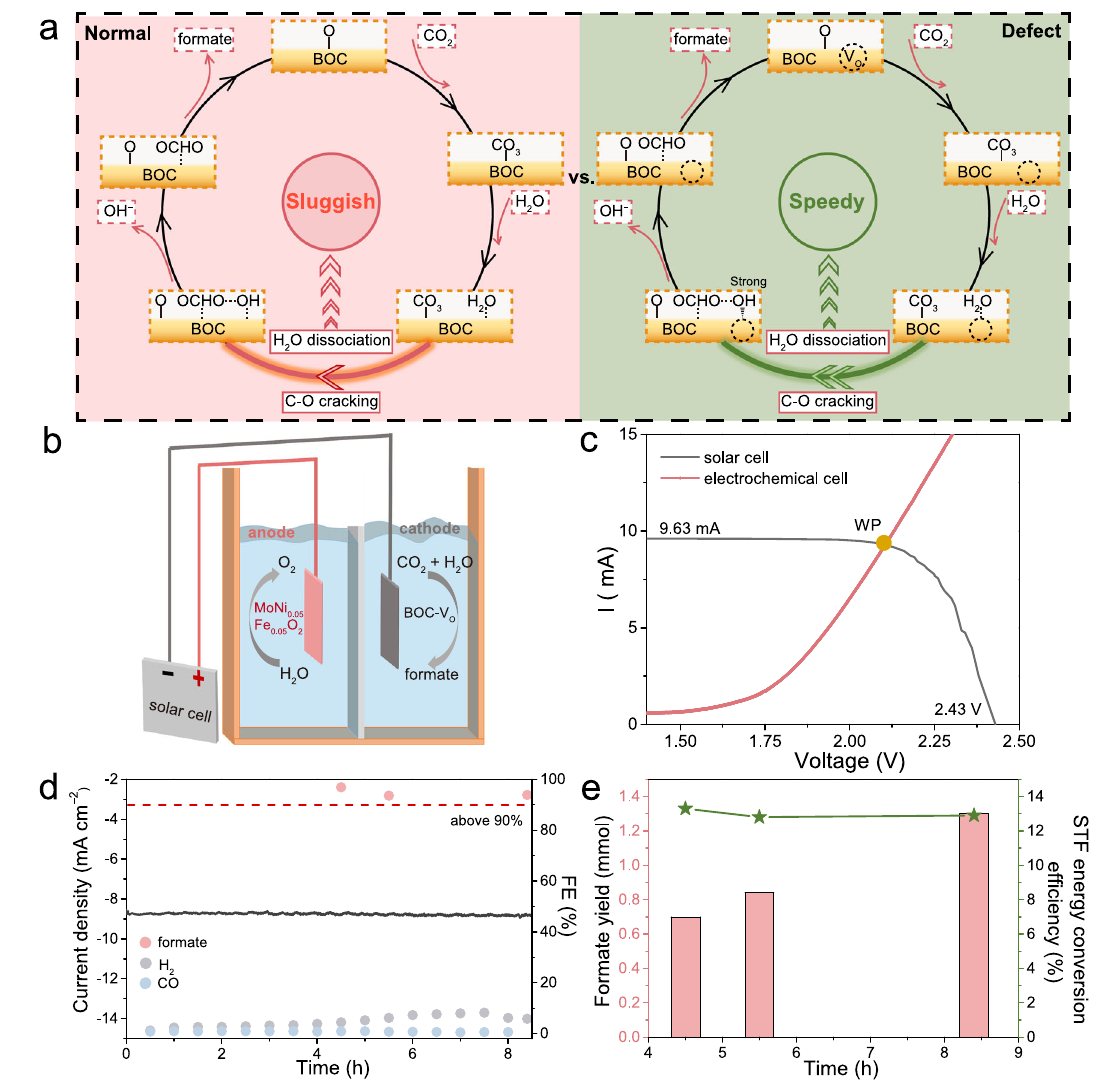
Fig.6|TheschmaticmechanismillustrationforBOCduringCO 2 RRtoformate and the construction of PV-EC system. a The schematic plot of the reaction pathways and the role of V O in CO 2 RR. b The schematic illustration of PV-CO 2 RR system. c I – V curves of the solar pannel and the polarization curves of this full-cell